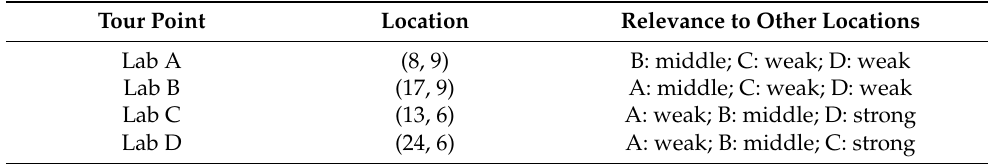
Table 5. Parameters for each point.